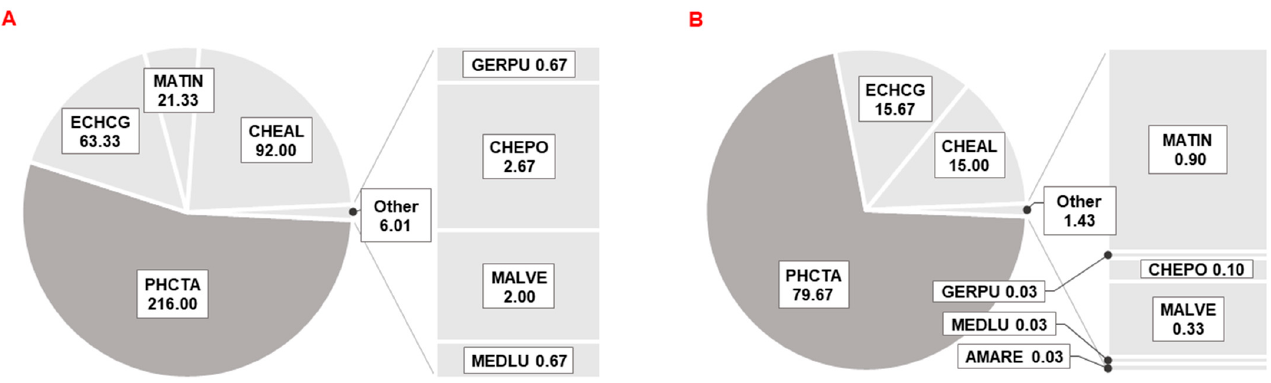
Figure A2. Number of plants per m 2 —Sowing 2 (24th of April) in 2018 ( A ) and leaf coverage in %—Sowing 2 (24th of April) in 2018 ( B ).